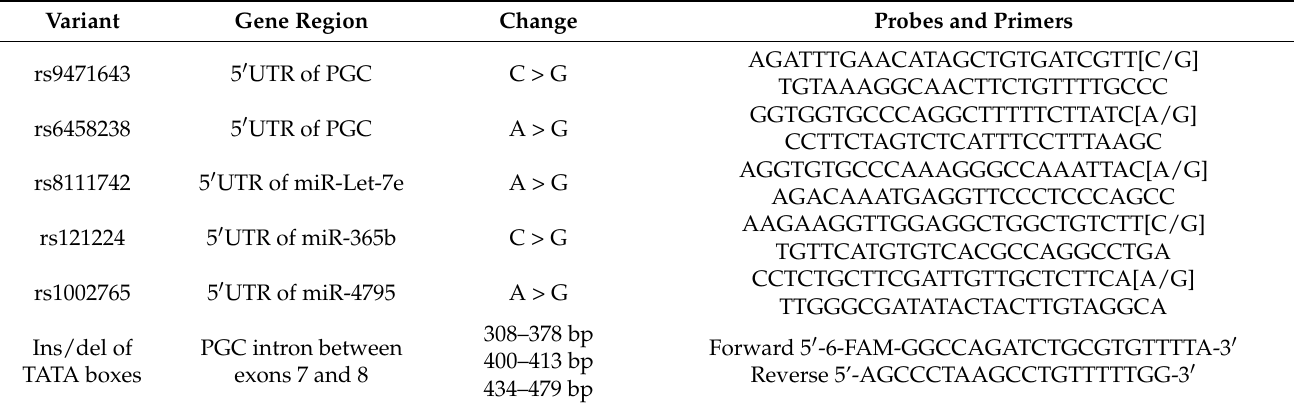
Table 1. Genetic variants tested for possible roles in regulating the expression of the PGC (Progastricsin) gene encoding pepsinogen